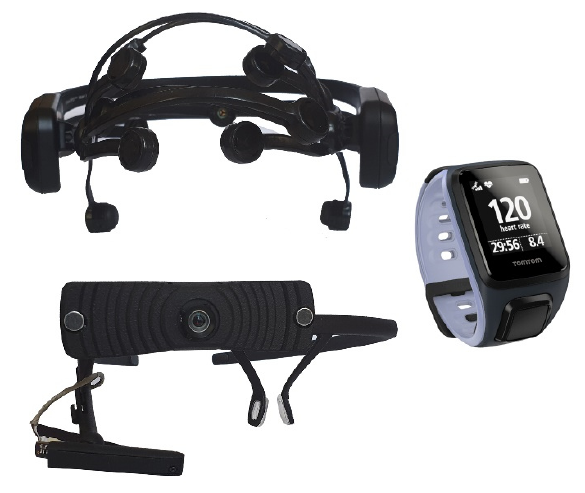
Figure 1- Devices used for experimentation.